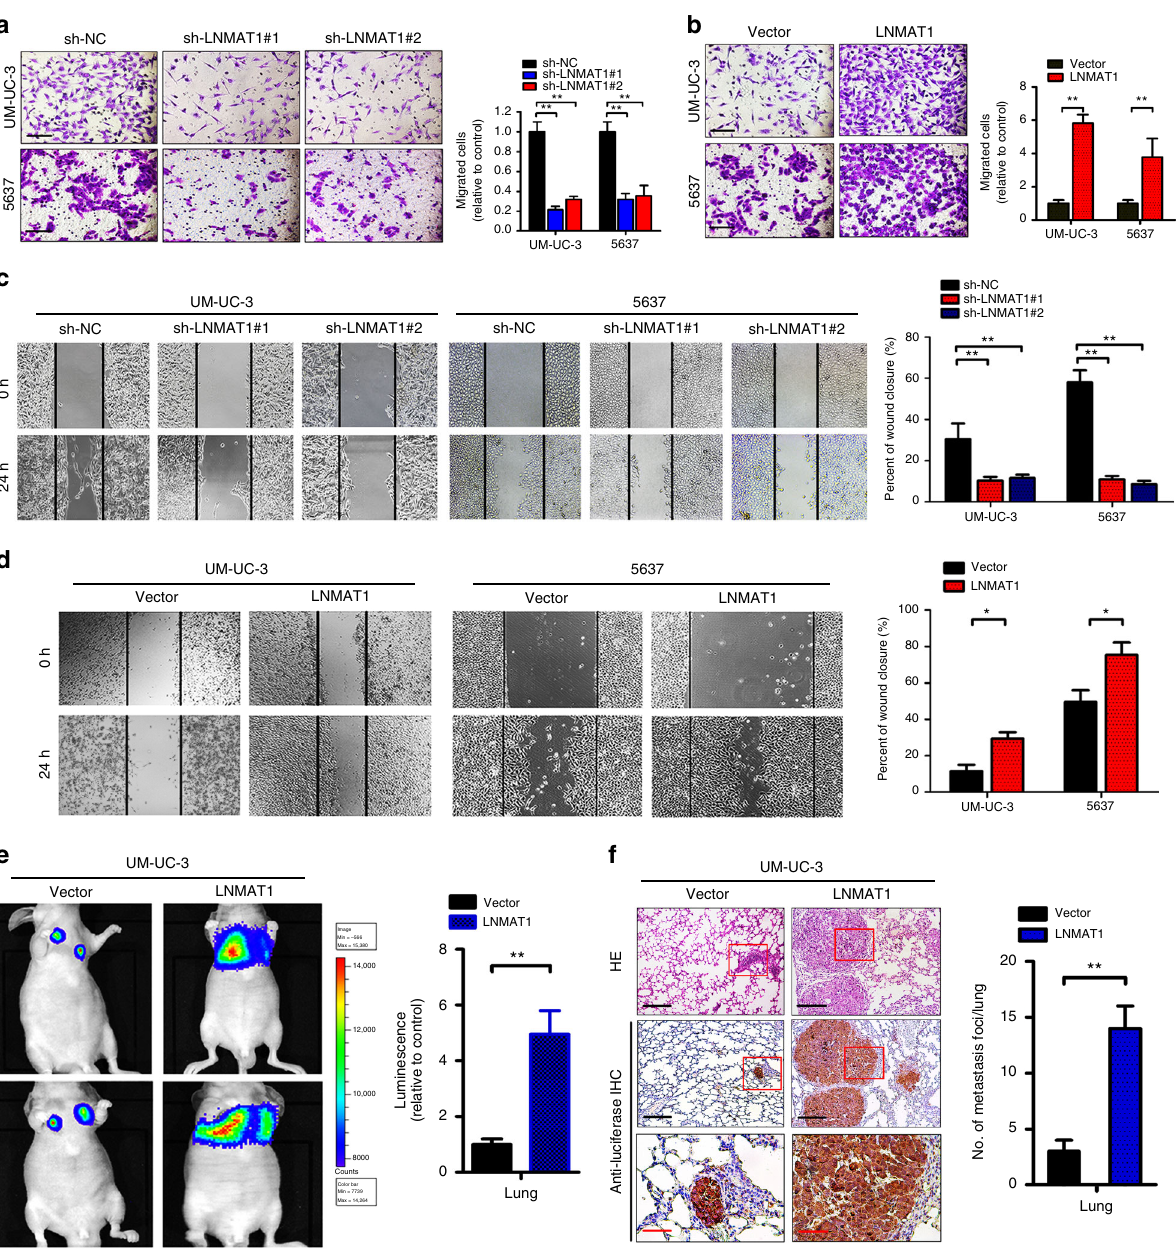
Fig. 3 LNMAT1 overexpression promotes bladder cancer cells invasion. a , b Representative images of Transwell assay using UM-UC-3 and 5637 cells showing cell motility after knockdown ( a ) or overexpression ( b ) of LNMAT1 and a histogram analysis of migrated cell counts are shown. Scale bars: 100 μ m. Statistical signi fi cance was assessed using two-tailed t -tests and one-way analyses of variance (ANOVA) followed by Dunnett ’ s tests for multiple comparison. c , d Representative images of wound healing assay using UM-UC-3 and 5637 cells (left panels) showing cell motility after knockdown ( c ) or overexpression ( d ) of LNMAT1 and a histogram analysis of cell migration distance are shown (right panels). Statistical signi fi cance was assessed using two- tailed t -tests and one-way analyses of variance (ANOVA) followed by Dunnett ’ s tests for multiple comparison. e – g Representative images of lung colonization by UM-UC-3 cells injected into the tail veins of nude mice, histogram analysis of luminescence and the number of metastatic foci representing lung metastasis measured on day 60 ( n = 16). Scale bars: black, 200 µ m; red, 50 µ m. Statistical signi fi cance was assessed using two-tailed t -tests and one- way analyses of variance (ANOVA) followed by Dunnett ’ s tests for multiple comparison. The error bars represent standard deviations of three independent experiments. * p < 0.05 and ** p <